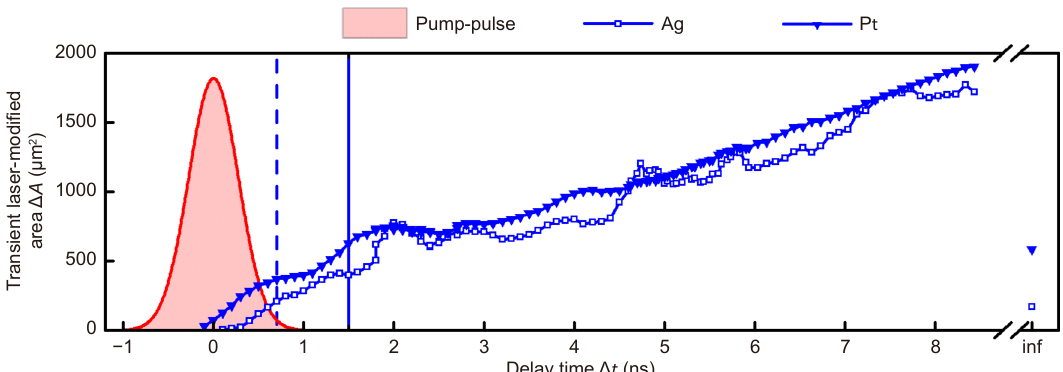
Fig. 4 | Transient laser-modified area Δ A for PPM of Ag (blue open squares) and Pt (blue solid triangles) targets at 8 J/cm 2 . The final state values of the laser-modified area are depicted at the Δ t labeled “inf” and the pump-pulse is indicated by a red area. Blue dashed and solid vertical lines mark the Δ t where Δ A exceeds the final state value for Ag and Pt, delay times of Δ t ≈ 0.7 ns (blue dashed vertical line) and Δ t ≈ 1.5 ns (blue solid vertical line) Δ A has exceeded the final state values of (170 ± 40) μm 2 and (580 ± 60) μm 2